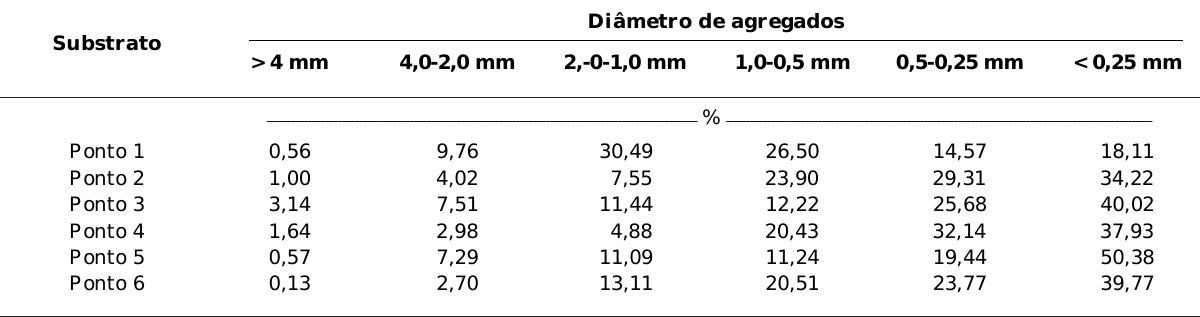
Quadro 2. Percentagem de agregados, determinada por via seca, referente à camada intermediária (~ 0-5